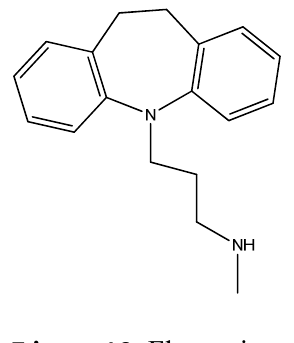
Figure 18. Fluoxetine.